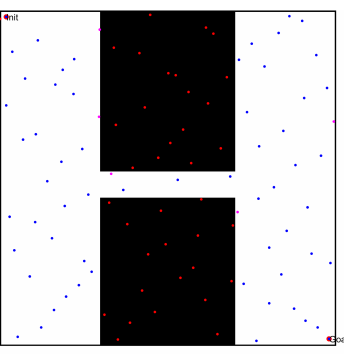
Figure 11. The distribution of sampling points in the working